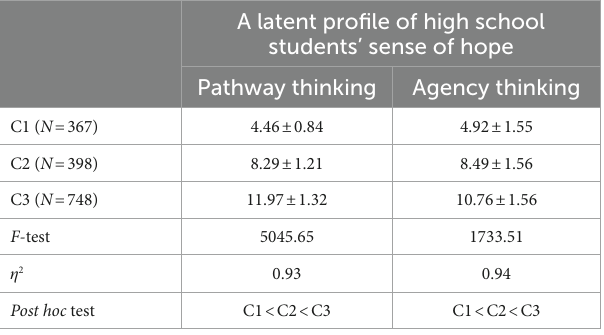
TABLE 4 Comparison of the status of sense of hope among high school students with different types of sense of hope. A latent profile of high